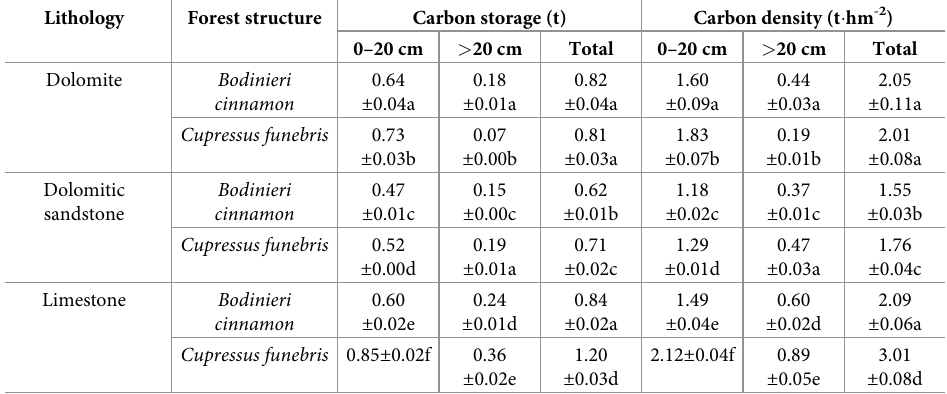
Table 11. Storage (400 m 2 ) and density of soil organic carbon in the two plantation species under different lithologies.